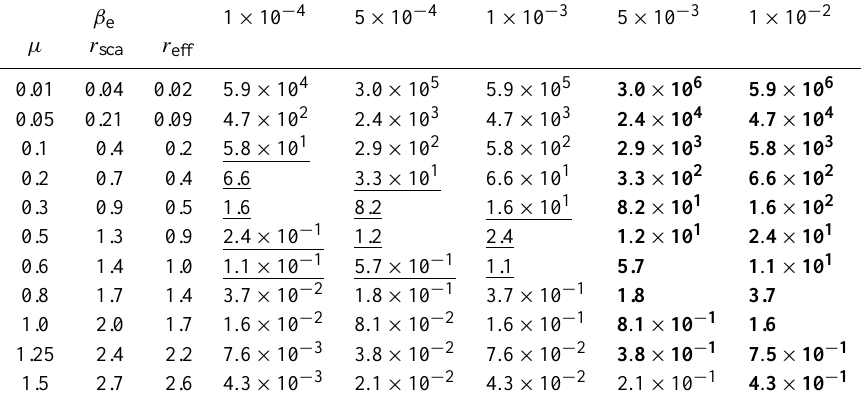
Table 5. Sulfate aerosol: number concentration n in cm − 3 for every median radius µ in µm and extinction coefficient β e in km − 1 . The most likely combinations of number concentration and particle size according to measurements (Mossop, 1964; Farlow et al., 1981; Deshler et al., 1992, 1993; Stothers, 2001; Bauman et al., 2003) are underlined. The scenarios exceeding the ash detection threshold are emphasised in bold font. β